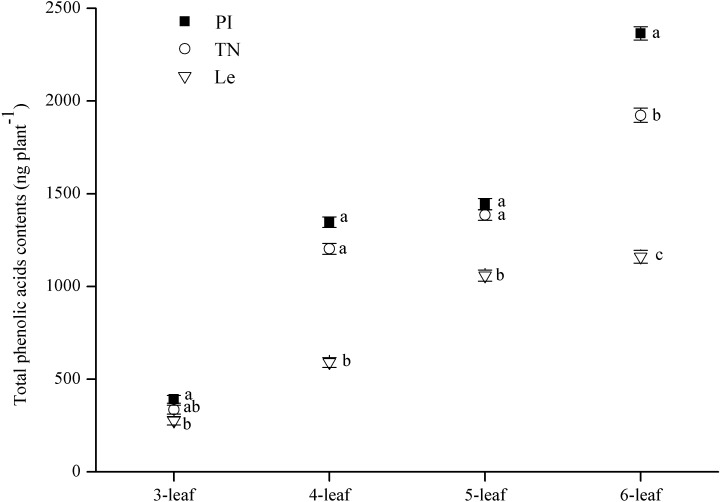
Total contents of eight phenolic acids in rice root-exudates at 3–6-leaf stage.Significant differences (P < 0.05) between rice species at the same leaf stage were indicated by different lowercases according to Tukey’s honestly test. PI and TN, allelopathic cultivars PI312777 and Taichung Native1. Le, non-allelopathic cultivar Lemont.